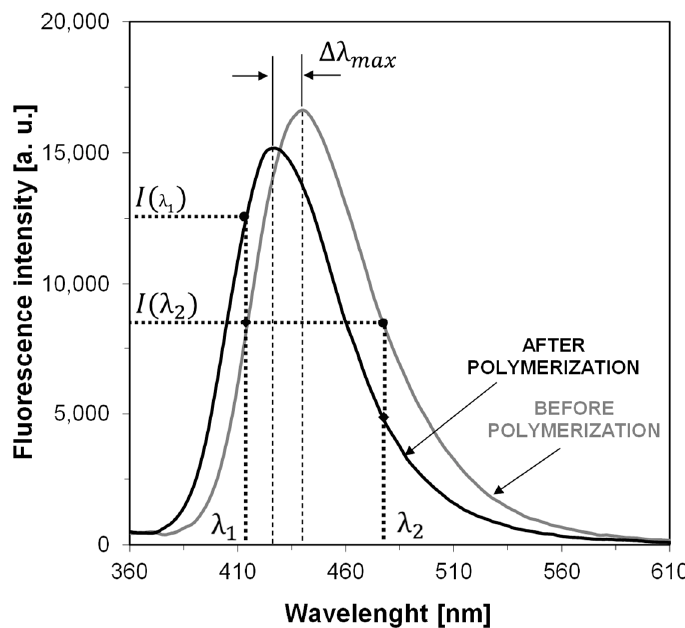
Figure 2. Changes of fluorescence spectra of example 2-amino-4-(4-cyanophenyl)-6-(4-methoxyphenyl) pyridine-3-carbonitrile sensor (S5) during free radical photopolymerization of TMPTMA monomer under irradiation 320 nm, ( λ 1 , λ 2 are monitoring wavelengths).